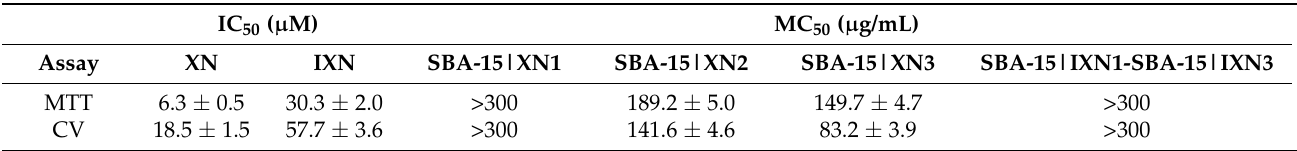
Table 2. IC 50 ( µ M) and MC 50 ( µ g/mL) values of free and immobilized XN and IXN into SBA-15 after 48 h of